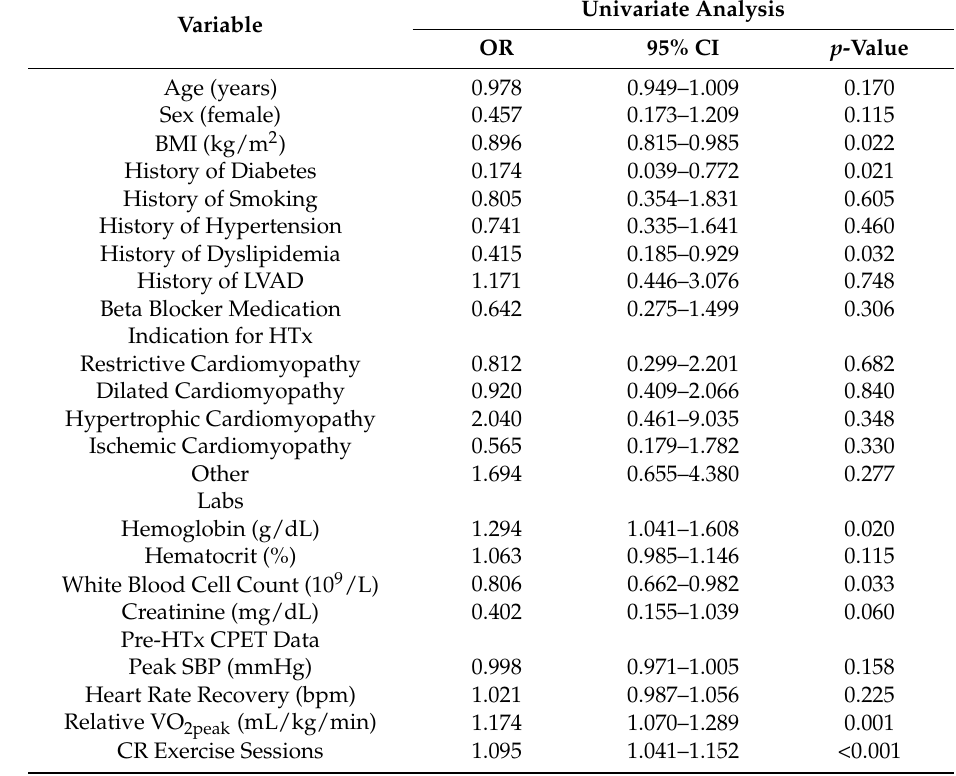
Table 3. Univariate regression analysis for predictors of VO 2peak .